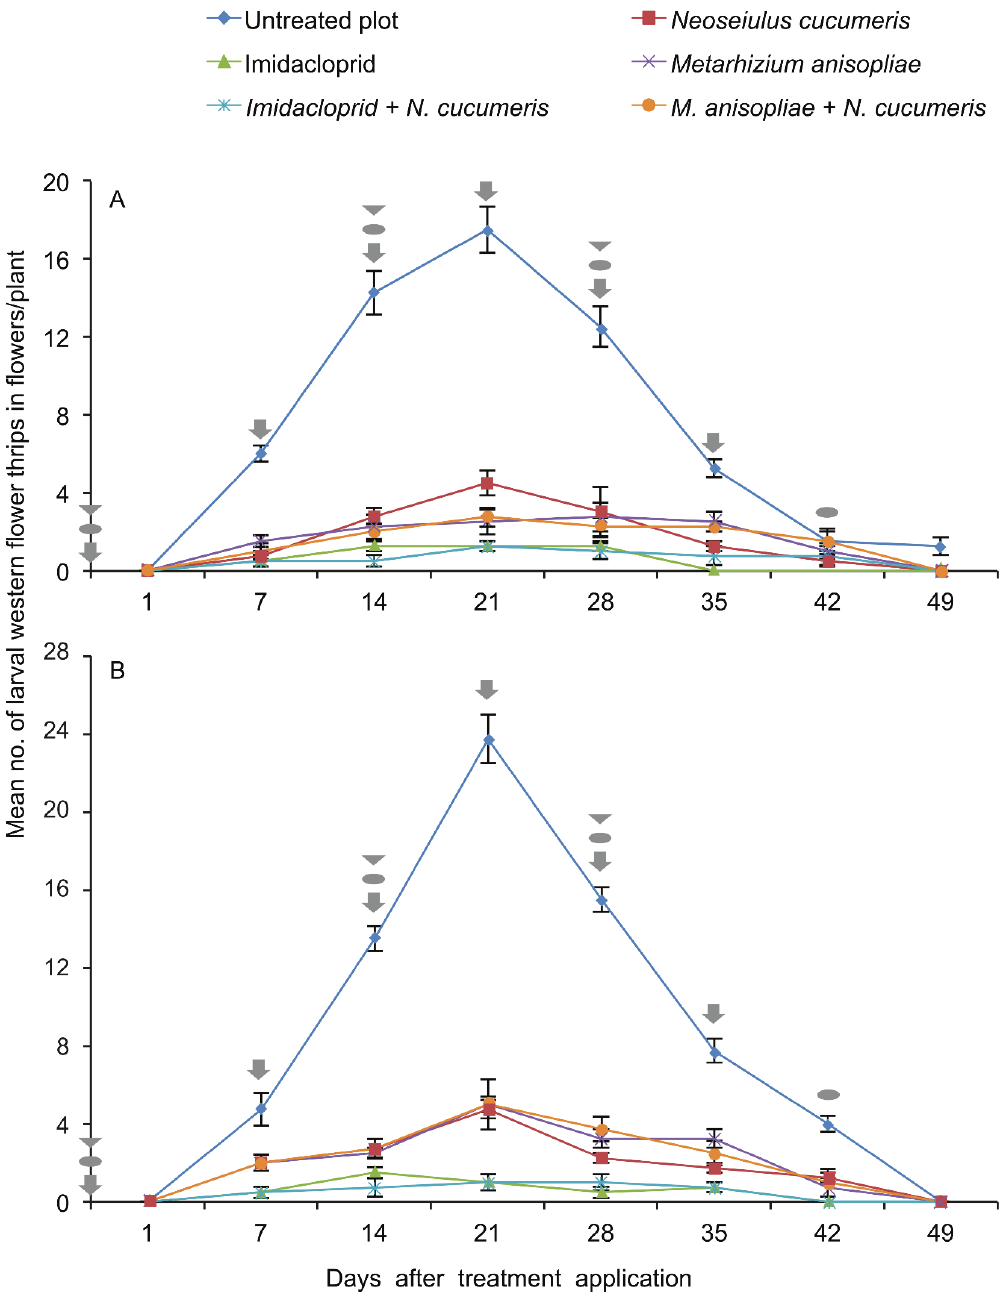
Figure 2. Mean (± SE) number of larval western flower thrips recorded on field-grown French beans in the various treatments over time by plant tapping in March to June ( A ) and June to September ( B ) 2011 at KALRO-Embu, Kenya. Where = application of imidacloprid in respective treatments; = release of Neoseiulus cucumeris in respective treatments; and = application of Metarhizium anisopliae in respective